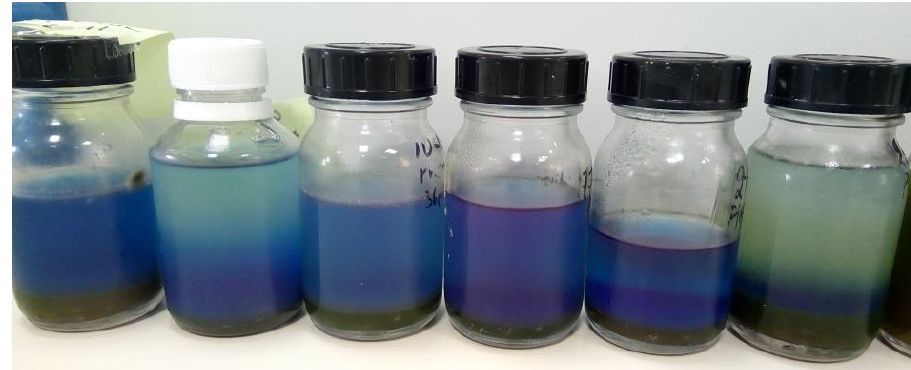
Figure 2. Samples of extracted phycocyanin after freezing and thawing of Phormidium sp.